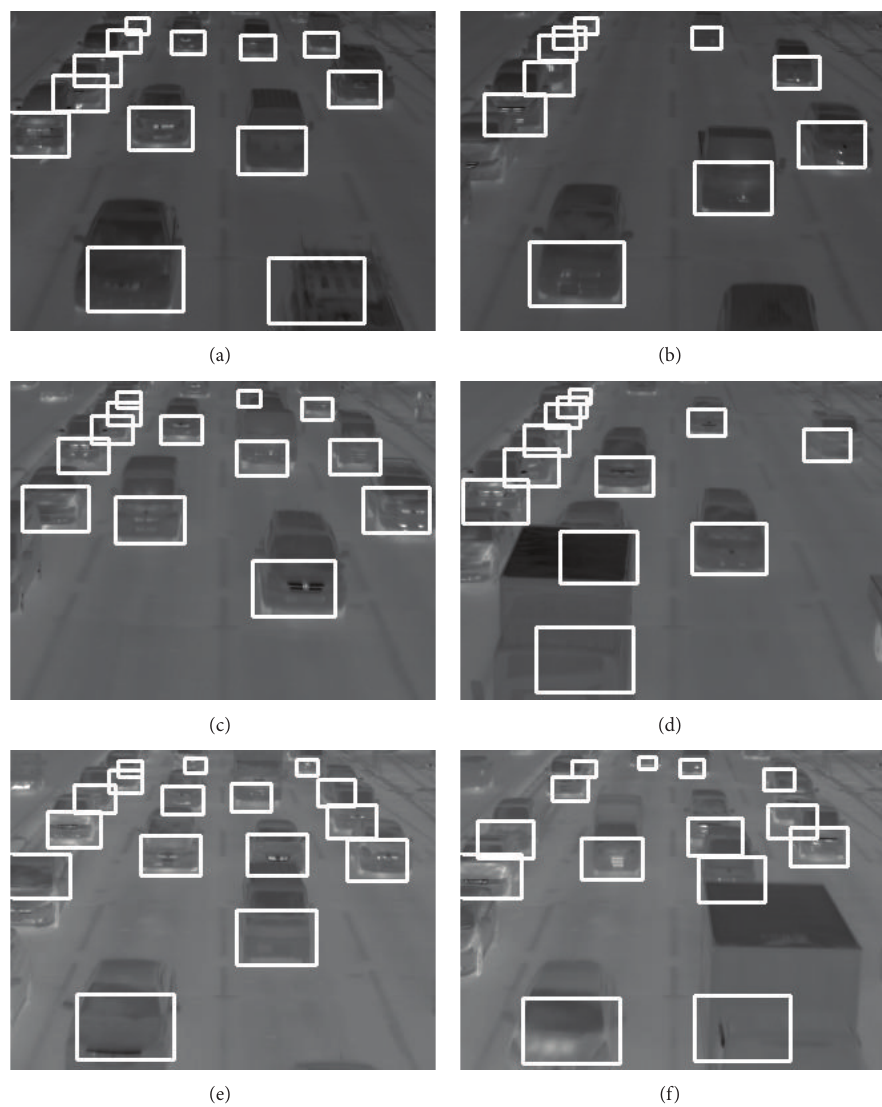
Figure 15: Six examples in detection results for the three video clips of thermal